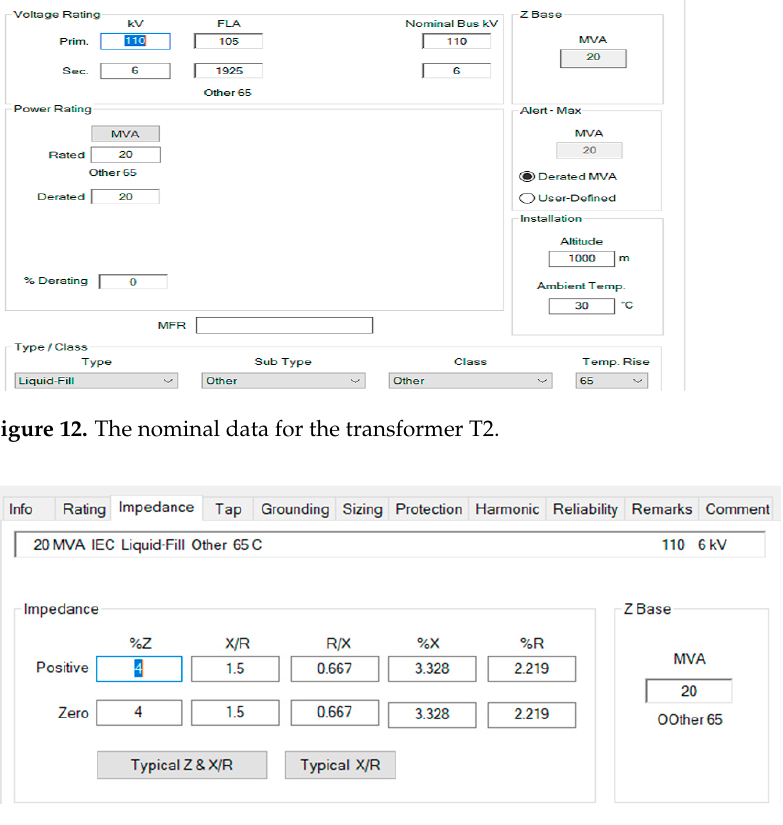
Figure 13. Percent impedance values for T2.